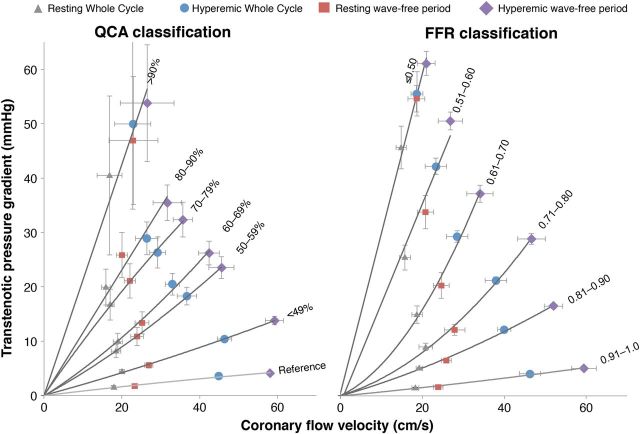
 Relationships between trans-stenotic pressure gradient and flow velocity for coronaries grouped by stenosis severity (left panel according to anatomical severity by percentage of diameter stenosis, and right panel according to physiological severity by fractional flow reserve). Relationships are described by trans-stenotic pressure gradient = A* flow + B* flow 2 and can be fitted by three points: the zero TG—zero flow crossing, the mean trans-stenotic pressure gradient and flow during whole cycle at rest, and during hyperaemia. Trans-stenotic pressure gradient and flow during the wave-free period closely follow these relationships, both at rest and during hyperaemic conditions. Curves are fitted by second-order polynomials.